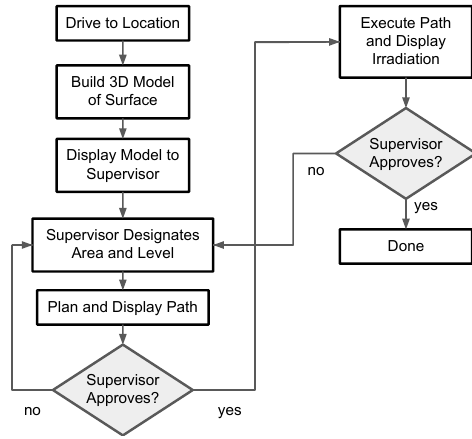
Figure 5. The flow of control in our system.